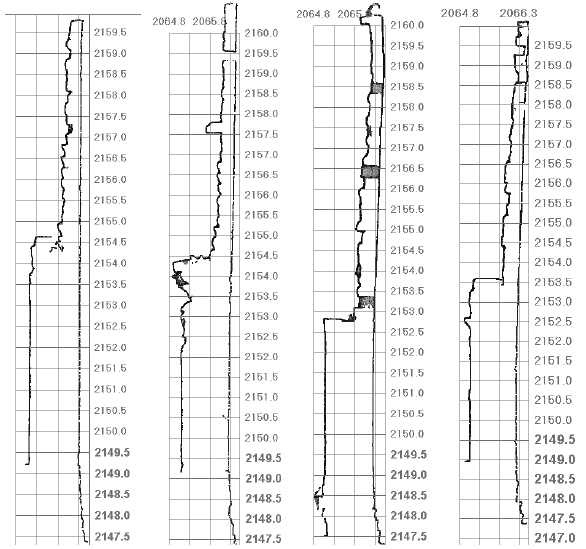
Figure 8: Sections through the eastern façade of the temple